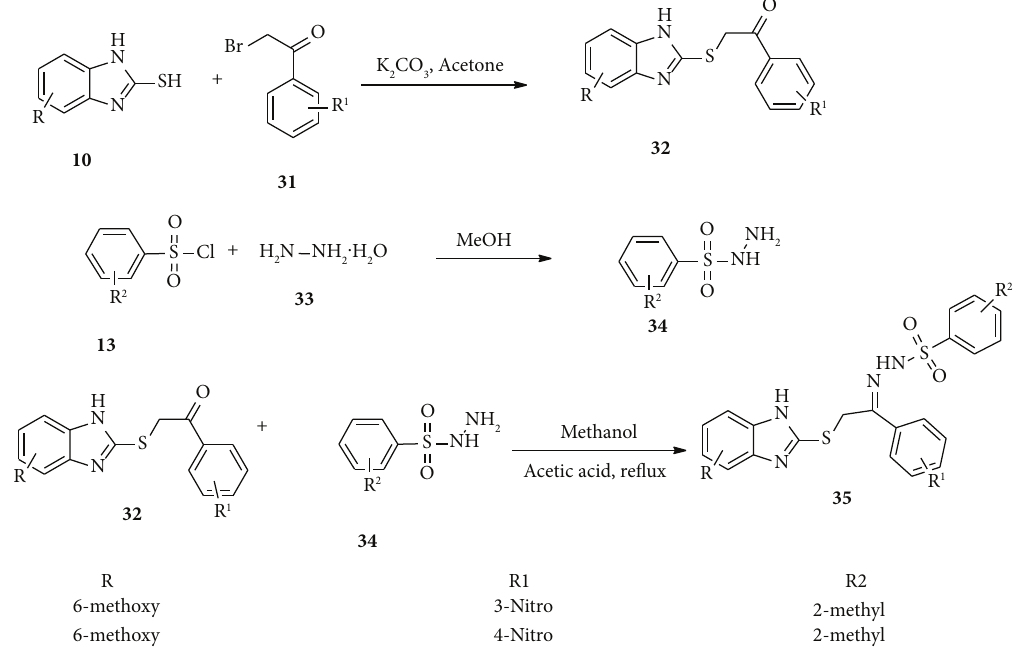
Scheme 6: Synthetic routes towards compound 35.